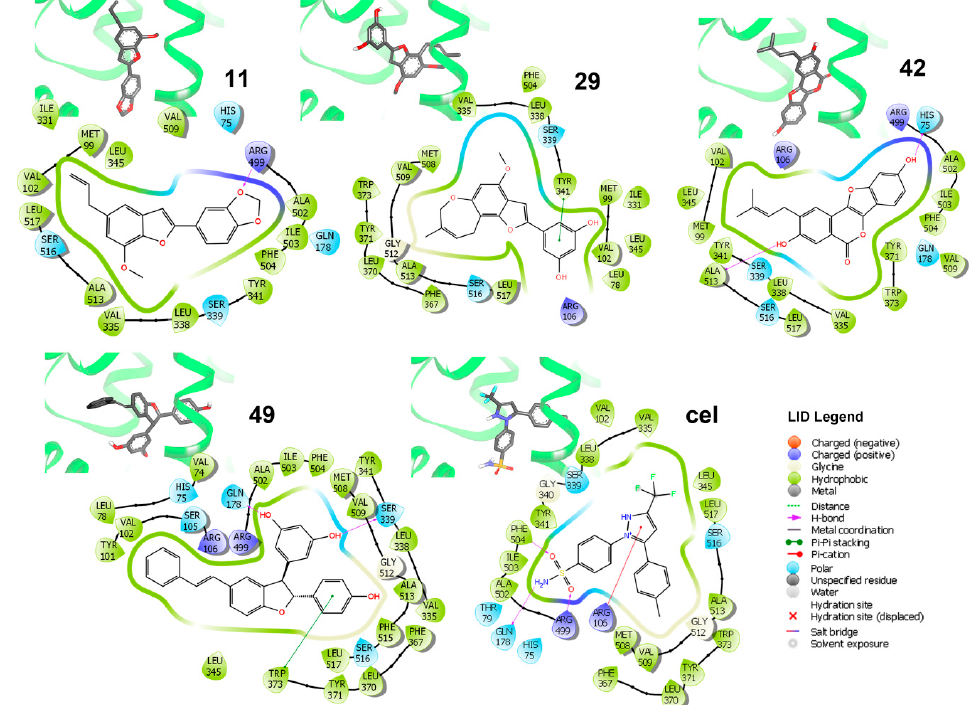
Figure 5. Three-dimensional (3D) models and ligand interaction diagrams (LID) of COX-2 · ligand complexes of the lowest-scored pose of the best docked compounds 11 , 29 , 42 , and 49 , as well as celecoxib (cel). In LID, light green, aquamarine, and purple lines depict the active site surface. Dark green arrows indicate the π - π stacking between residues and aromatic moieties of compounds. Magenta arrows indicate the H -bonding. Residues are differentiated by colors according to the interaction type as indicated in the LID legend: hydrophobic (green), polar (aquamarine), and a positive charge (purple). 3D-models showed docked compounds in bold sticks and enzymes as a light green cartoon.